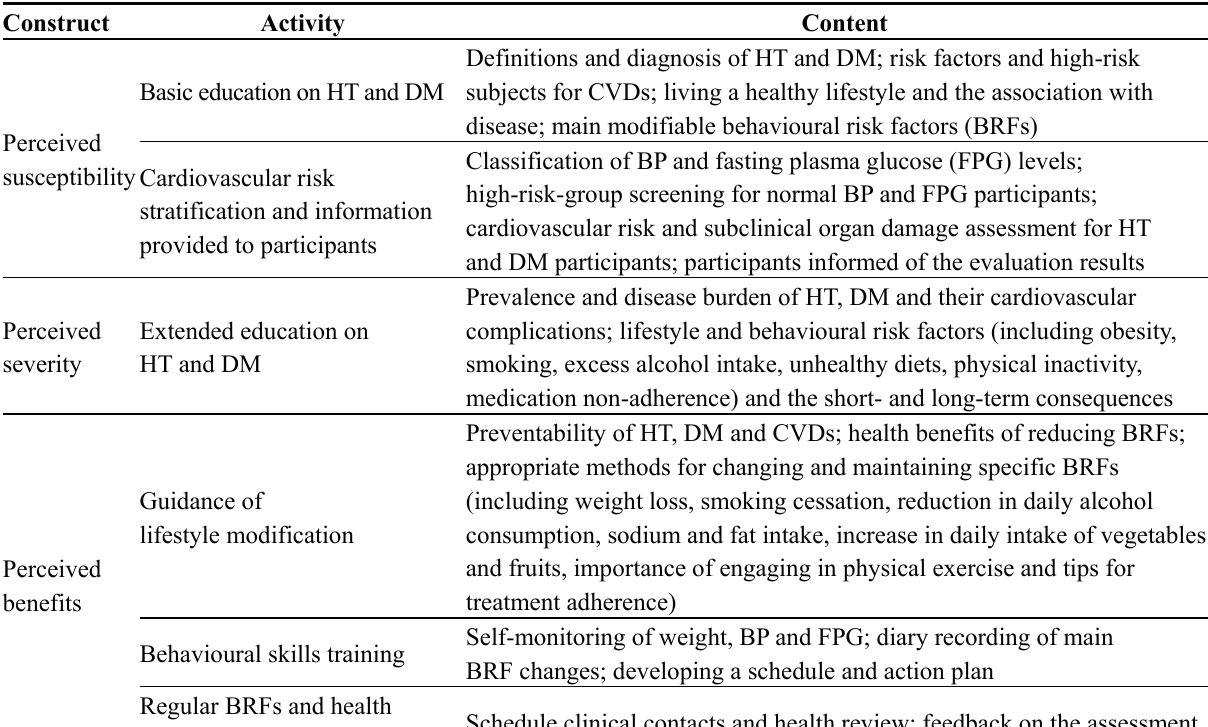
Table 1. Overview of intervention activities and healthy lifestyle